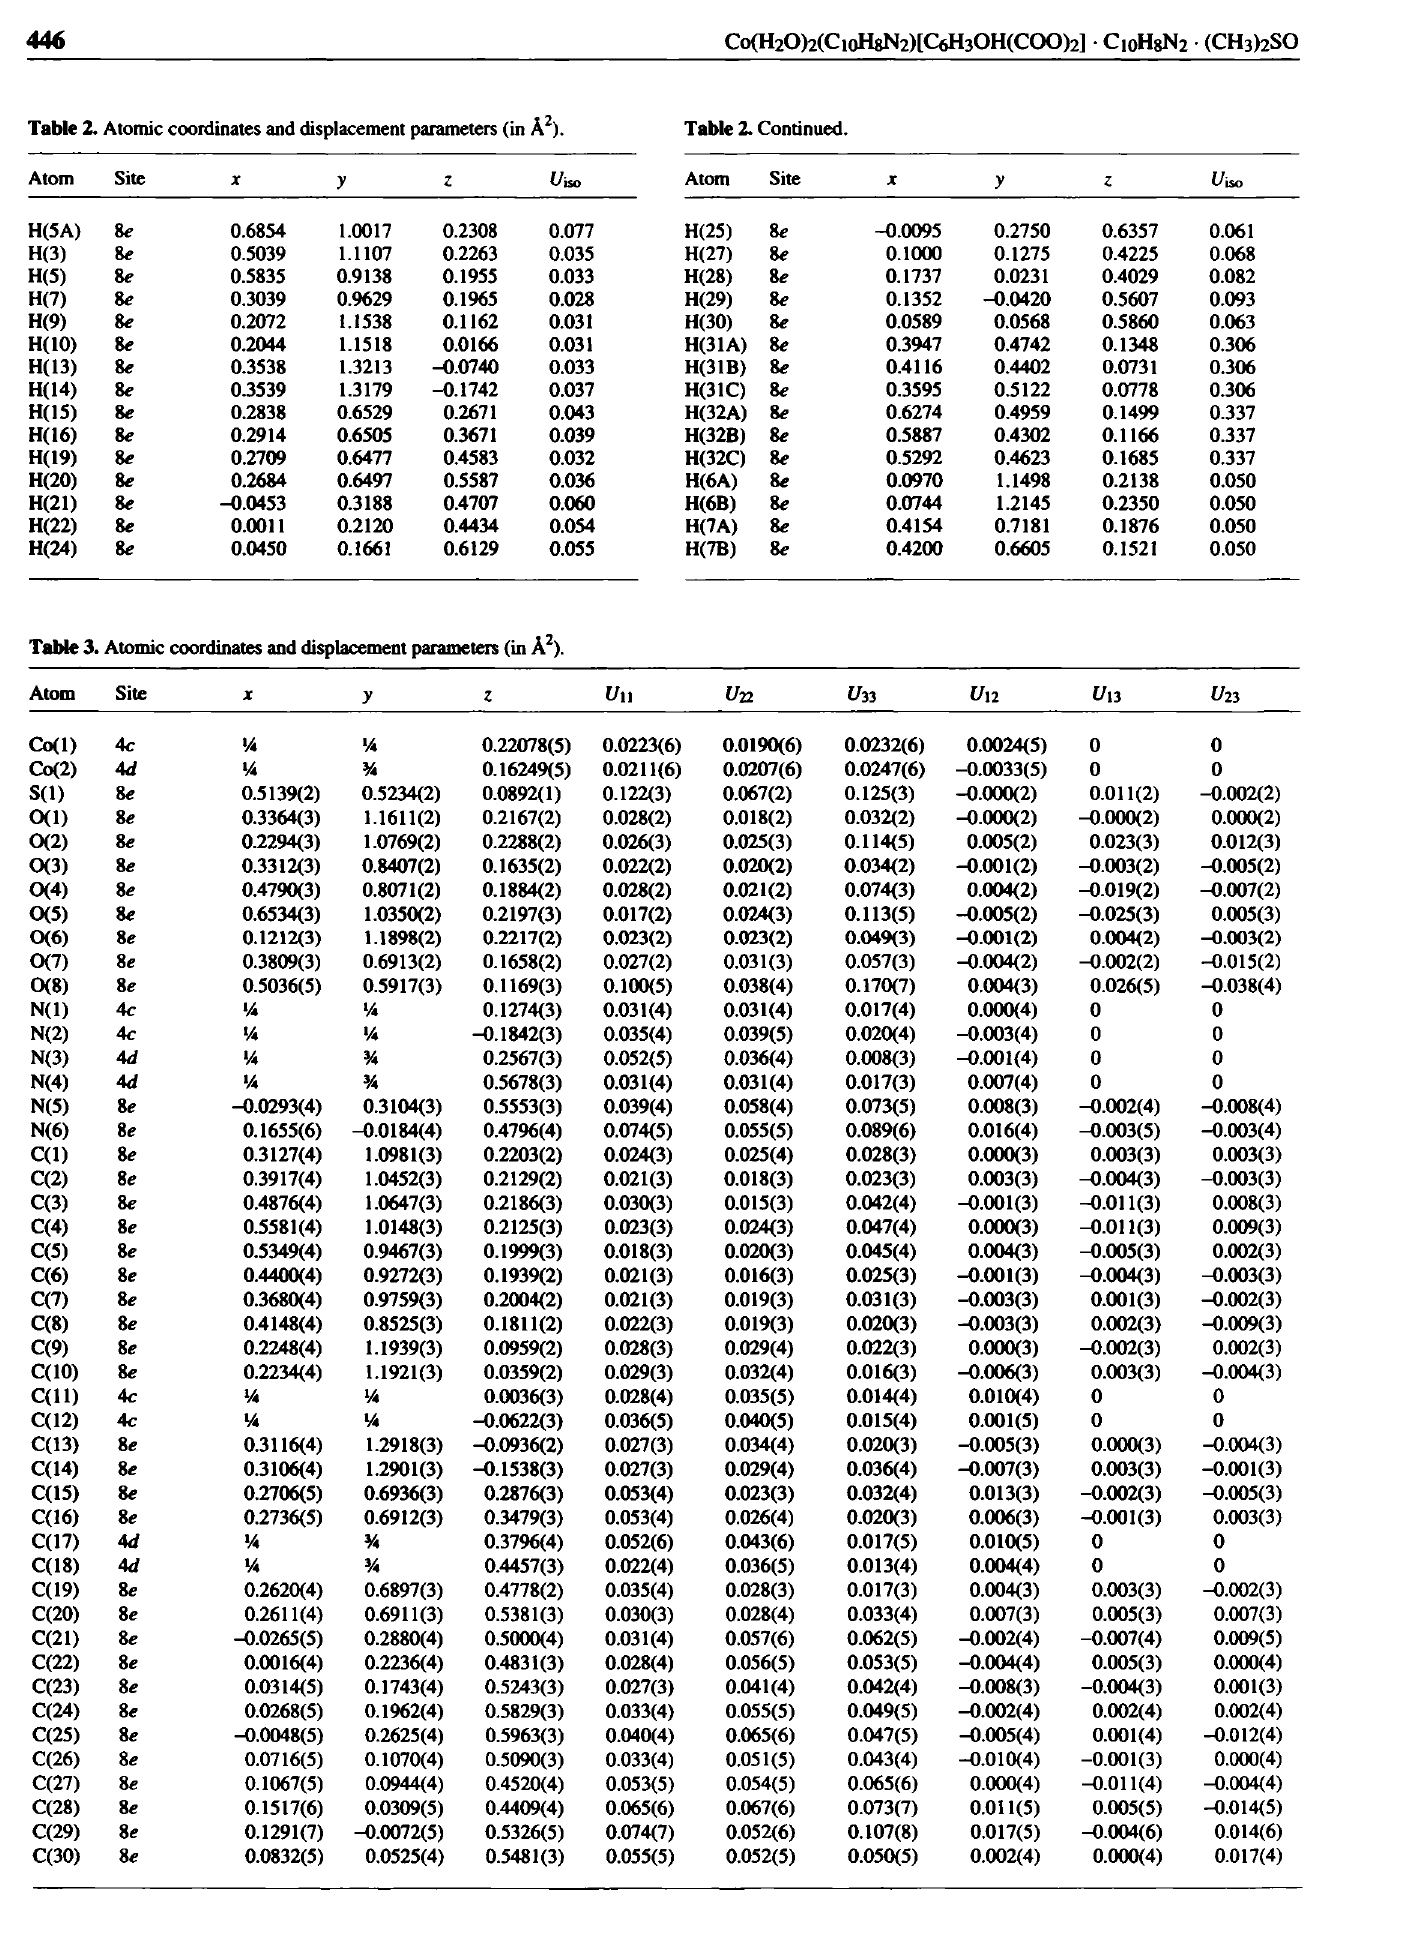
Table 2. Atomic coordinates and displacement parameters (in Ä 2 ). Table 2. Continued.